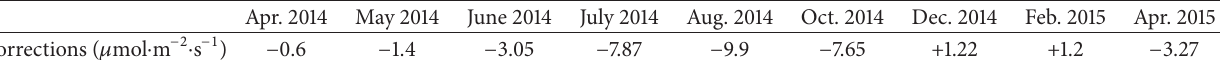
Table 2: Corrections made to CO 2 measurements from April 2014 to April 2015 (February 2014 is the baseline, uncorrected) from gas measuring point number 7.